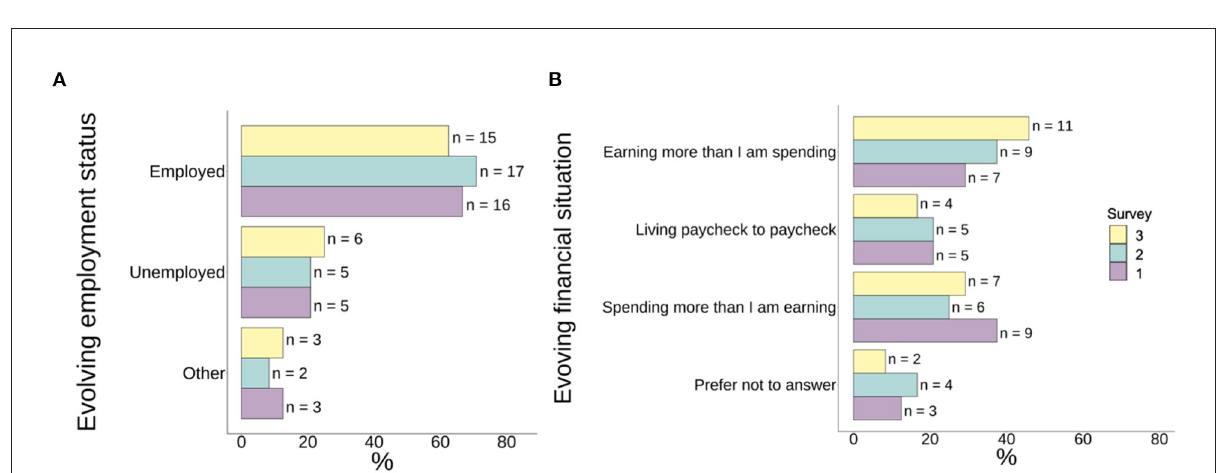
FIGURE3 Civic scientists’ evolving: (A) employment status and (B) financial situation. 1, 2, and 3 represent survey numbers (1: beginning, 2: middle, and 3: end). In (A) , “Other” represents people who are students or